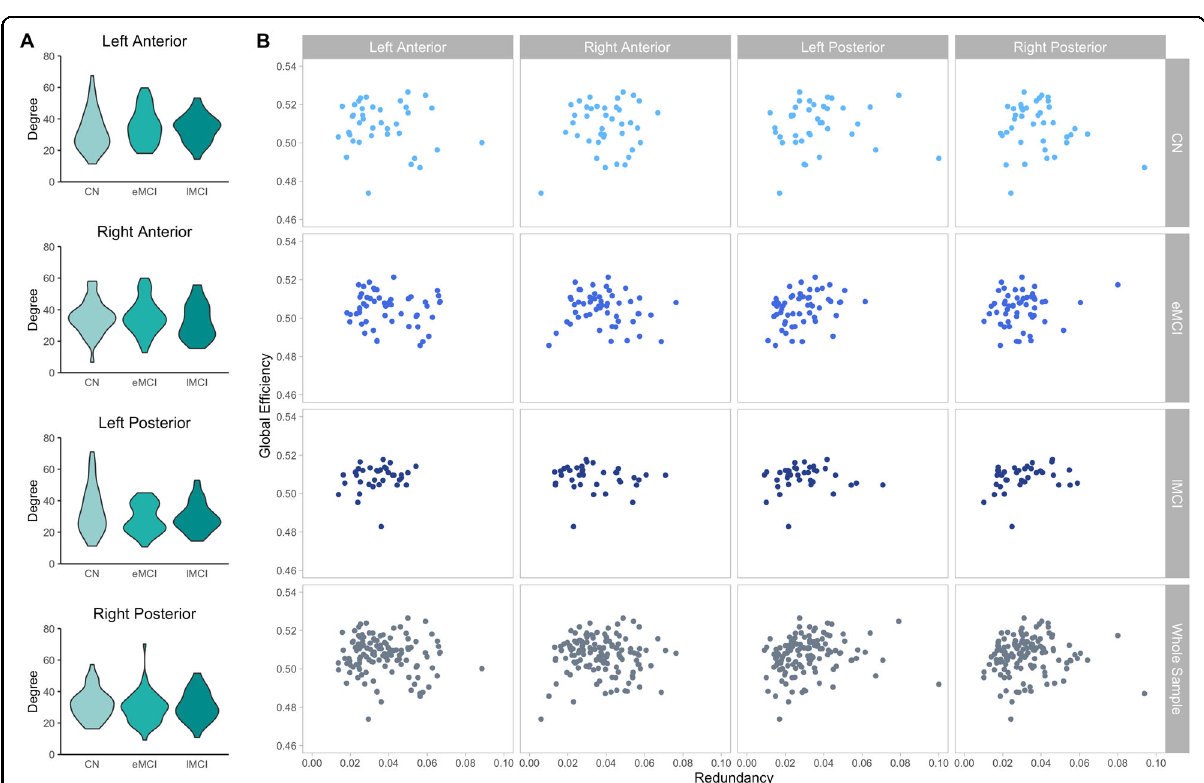
Fig. 4 Degree and global ef fi ciency. A Group comparisons of degree in each hippocampal ROI. B Global ef fi ciency regressed on hippocampal redundancy in each ROI within each group and collapsing across